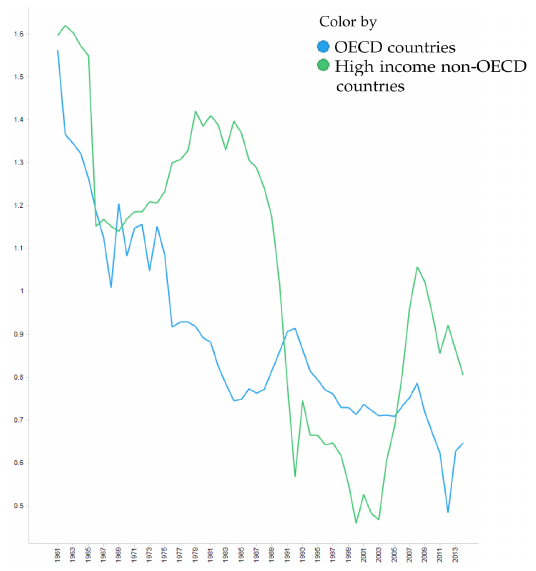
Figure A1. Population growth rate for OECD and (high-income) non-OECD